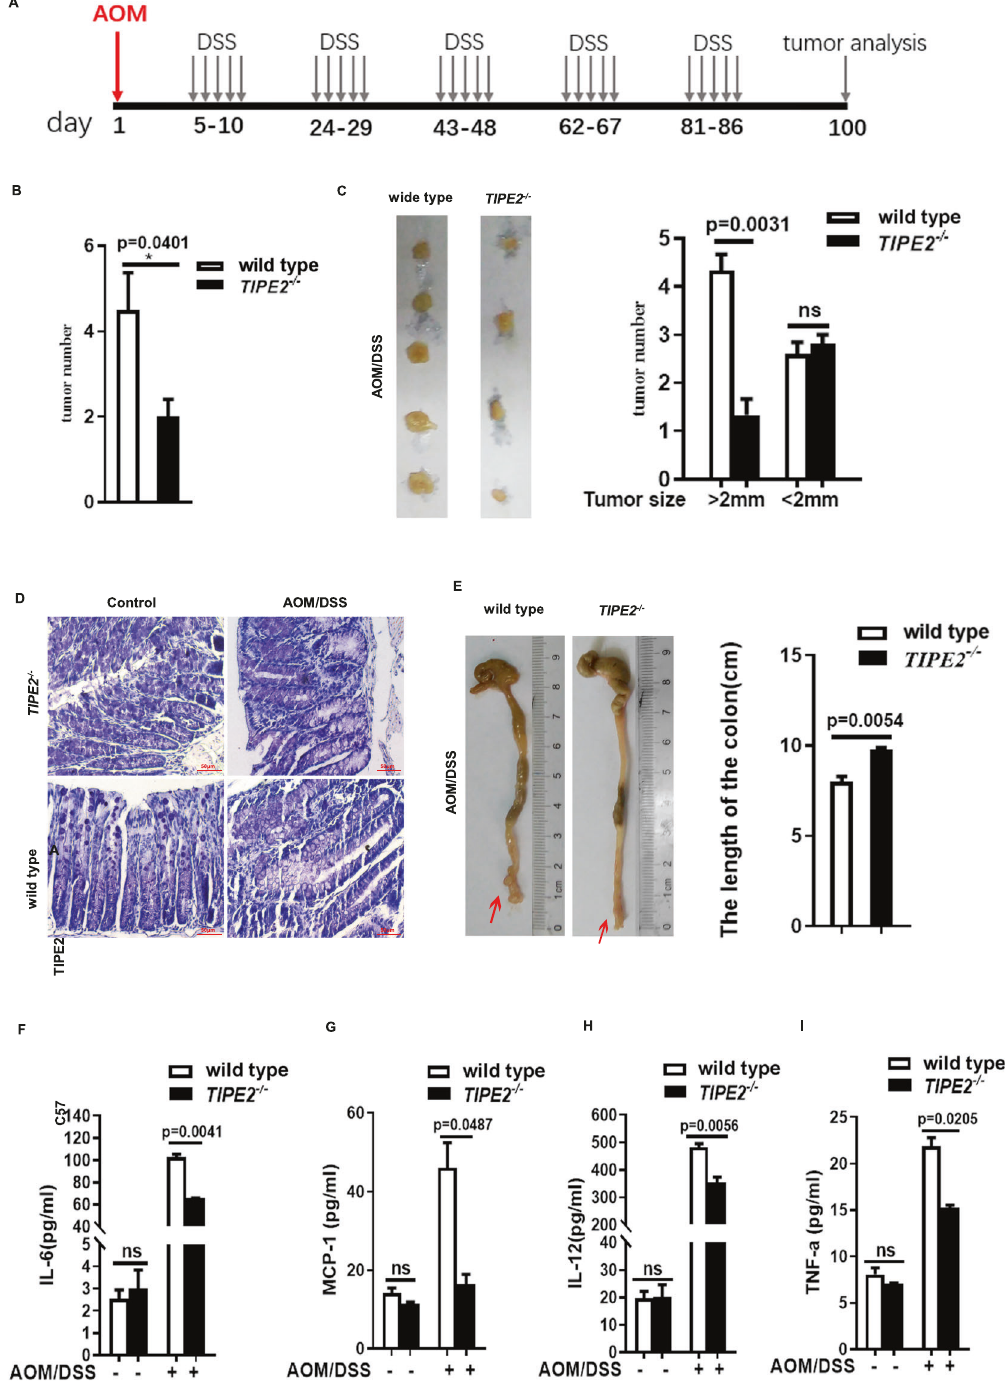
Fig. 5 Tiep2 -de fi cient mice were more resistant to AOM/DSS-induced tumorigenesis. A The protocol of AOM/DSS-induced CRC. The tumor number was signi fi cant lower in Tipe2 -de fi cent AOM/DSS models ( B ), especially tumors less than 2 mm in diameter ( C ). Tipe2-de fi ency showed less severe intestinal morphology ( D ) accompanied by longer length of the colon ( E ) in AOM/DSS-induced mice. Tipe2 -de fi cent AOM/DSS models showed lower serum levels of proin fl ammatory cytokines, such as IL-6 ( F ), MCP-1 ( G ), IL-12 ( H ) and TNF- α ( I ). Data are representative of three independent experiments and expressed as means ± SEM. Signi fi cant difference between two groups was determined using an unpaired two-tailed Student ’ s t -test. * P < 0.05, ** P < 0.01, *** P <